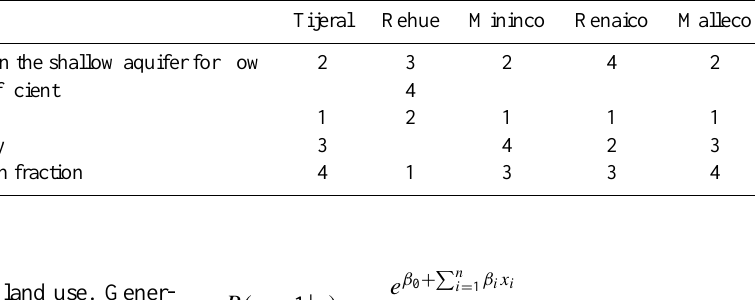
Table 6. Ranking of the four most sensitive parameters in Tijeral, Rehue, Renaico, Mininco and Malleco. Parameter Description Tijeral Rehue Mininco Renaico GWQMN Threshold water depth in the shallow aquifer for flow GW REVAP Groundwater revap coefficient CN2 SOL AWC Available water capacity rchrg dp Deep aquifer percolation